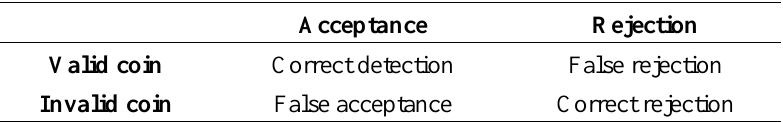
Table 1. Decision categories for valid and invalid coins.